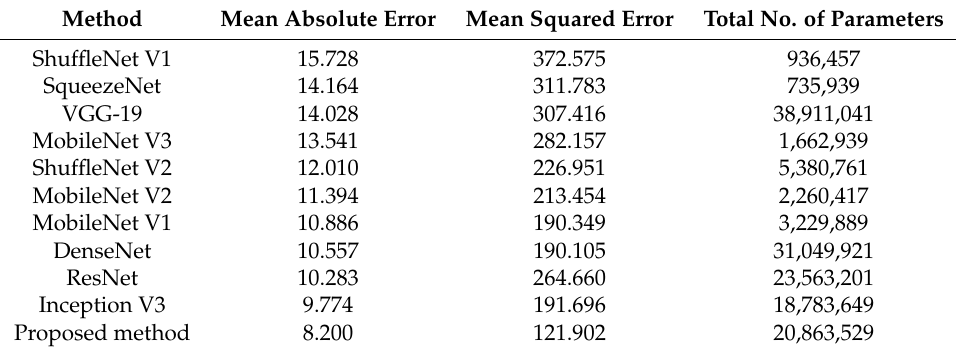
Figure 9. Training graphs of mean squared error for all tested methods. Only the results for the first 40 epochs are shown to produce good visualization. Table 2. Experimental results of the proposed method and the benchmarked